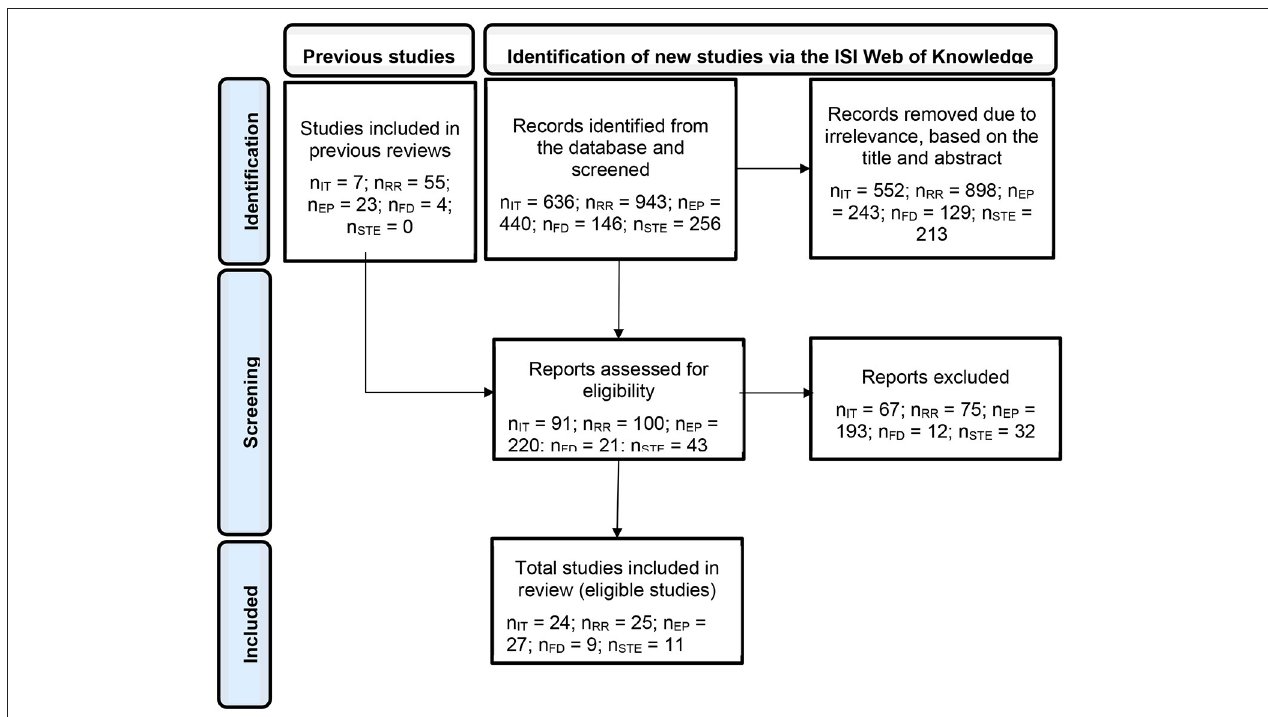
FIGURE 2 | Flow diagram for the systematic review of the five coexistence topics: invasibility tests (IT), resource-ratio (RR), natural enemy partitioning (EP), frequency-dependent exploitation by generalist enemies (FD), and the storage effect (STE). “n” is the sample size.